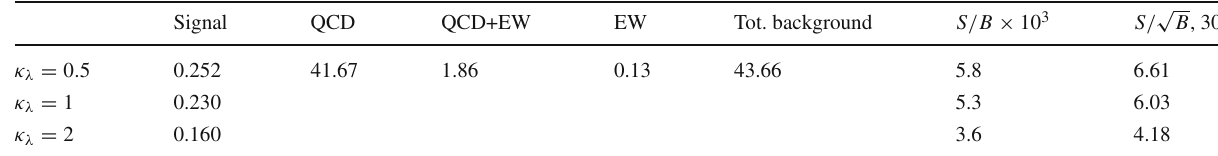
Fig. 6 Normalised differential soft-dropped mass m SD (left) and N-subjettiness ratio τ 2 , 1 (right) for the leading reconstructed fat jet. The observables are used for the Higgs-jet